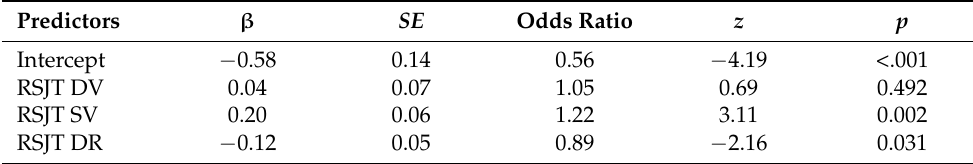
Table 6. Predicting figural analogy accuracy with all three RSJT measures. Predictors β SE Odds Ratio